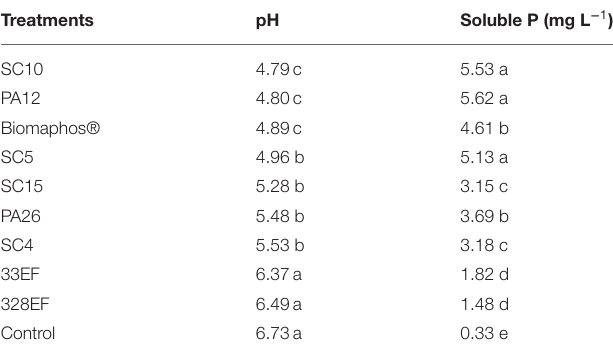
TABLE 3 | Evaluation of calcium phosphate (CaHPO 4 ) solubilization in liquid medium (GL) by rhizospheric or endophytic bacterial and fungal strains